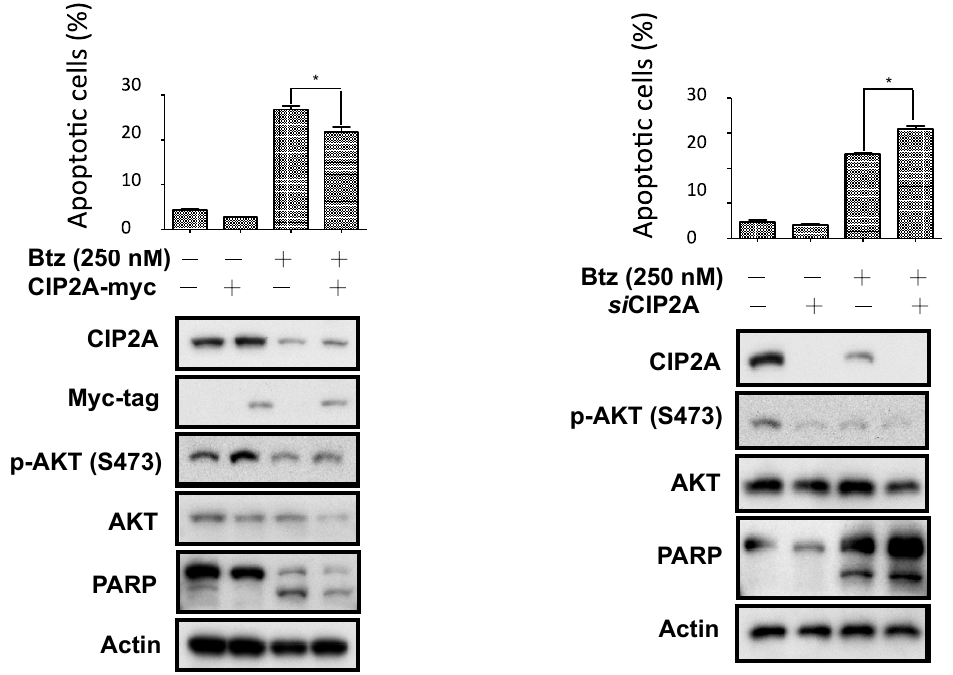
Figure 6. CIP2A mediated brotezomib-induced apoptosis through p-Akt regulation. Cell were transfected with CIP2A siRNA ( right ) and ectopic expression of CIP2A ( left ), then treated with brotezomib (250 nM) for 24 h. cells were analysis by western blot and flow cytometry. Points , mean; bars , S.D.; * Difference is statistically significant ( p < 0.05); n =